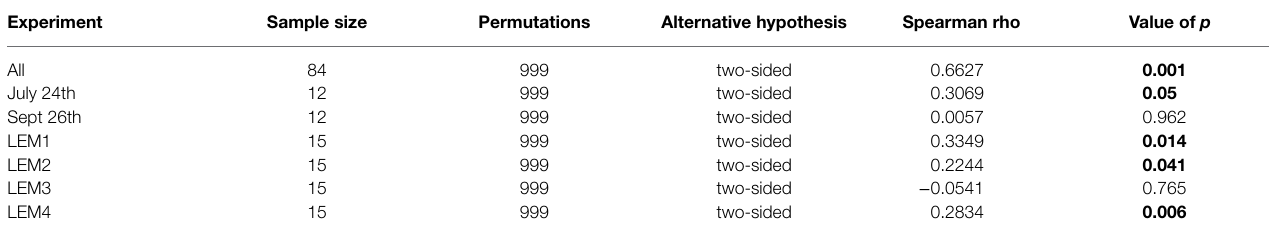
TABLE 3 | Spearman’s rank-order correlations between fluorometrically quantified cyanobacterial biomass and the beta diversities of bacterial communities within the phycosphere of Microcystis colonies for each experiment and all experiments. Experiment Sample size